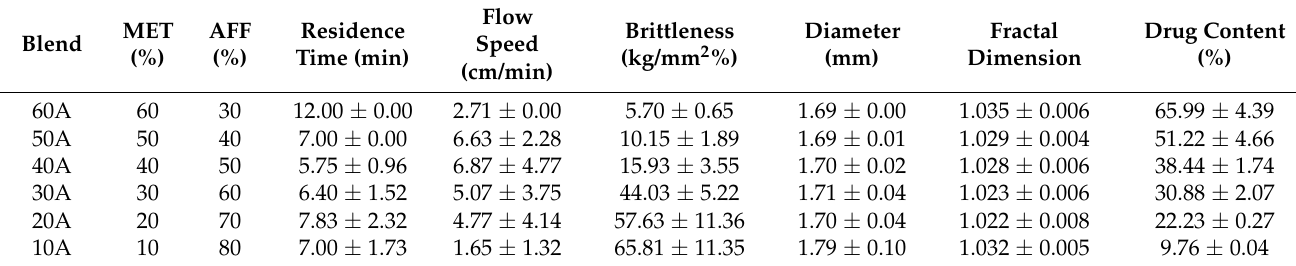
Table 3. Extrusion process parameters and filament parameters of blends containing 5% of both MS and PEG 6000 with 10% to 60% MET.